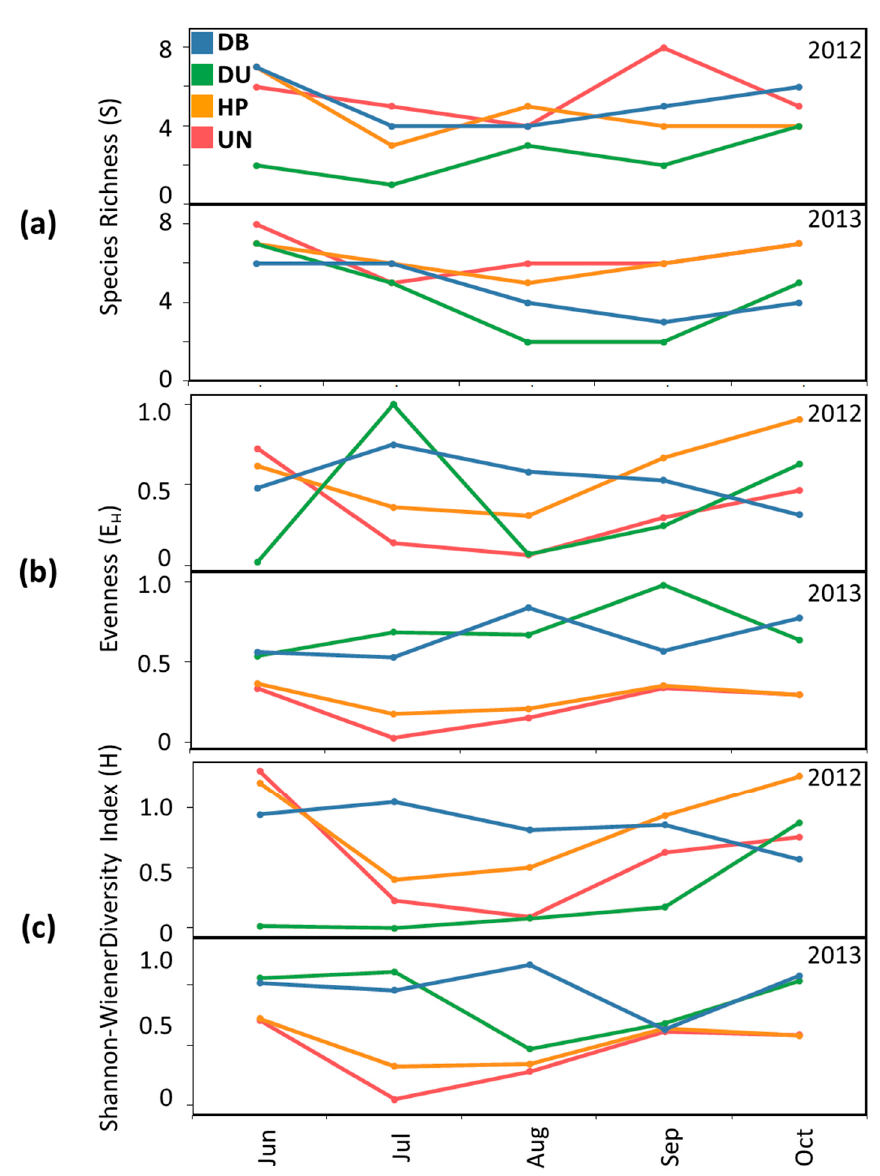
Figure 6. Seasonal changes in ( a ) species richness, ( b ) species evenness, and ( c ) Shannon–Wiener Diversity Index from the four stations Dabob (DB), Duckabush (DU), Hoodsport (HP), and Union (UN) in 2012 and 2013.